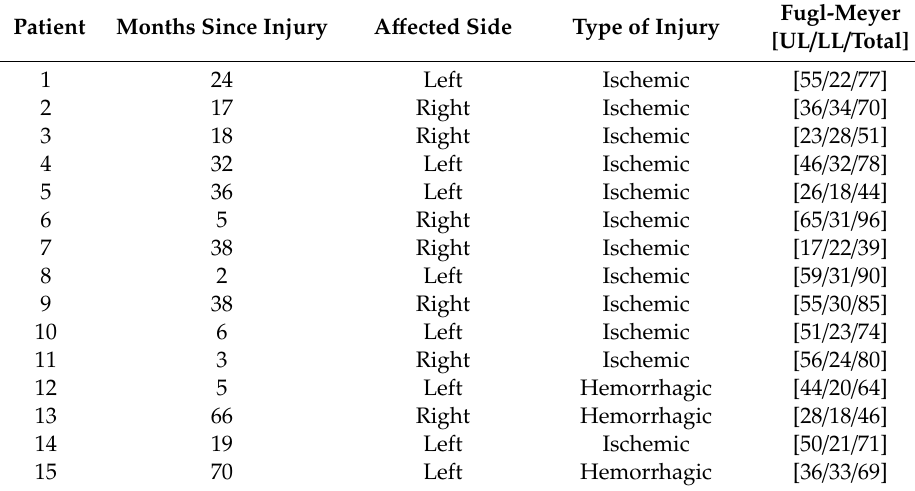
Table 1. Patient demographics. Upper limb (UL), and lower limb (LL). The maximum score is 66 and 34 for UL and LL,